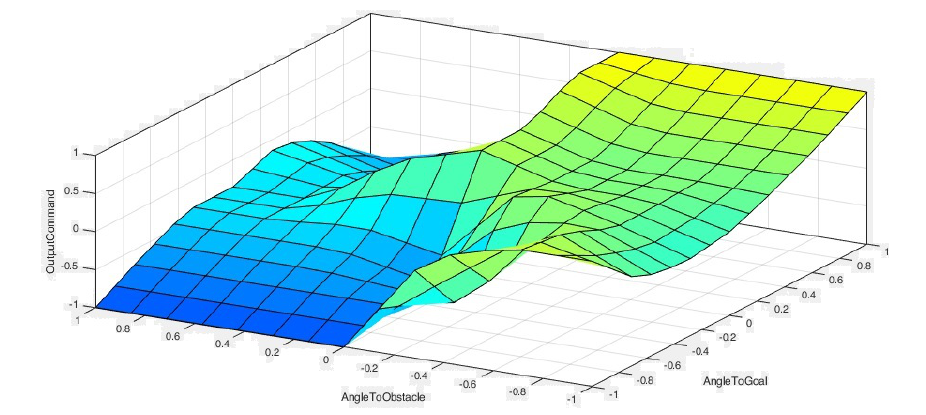
Figure 7. Fuzzy Surface of the Obstacle-Avoidance